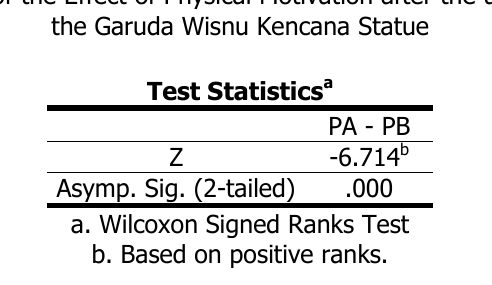
Table 3. Statistical Test of the Effect of Physical Motivation after the after The Inauguration